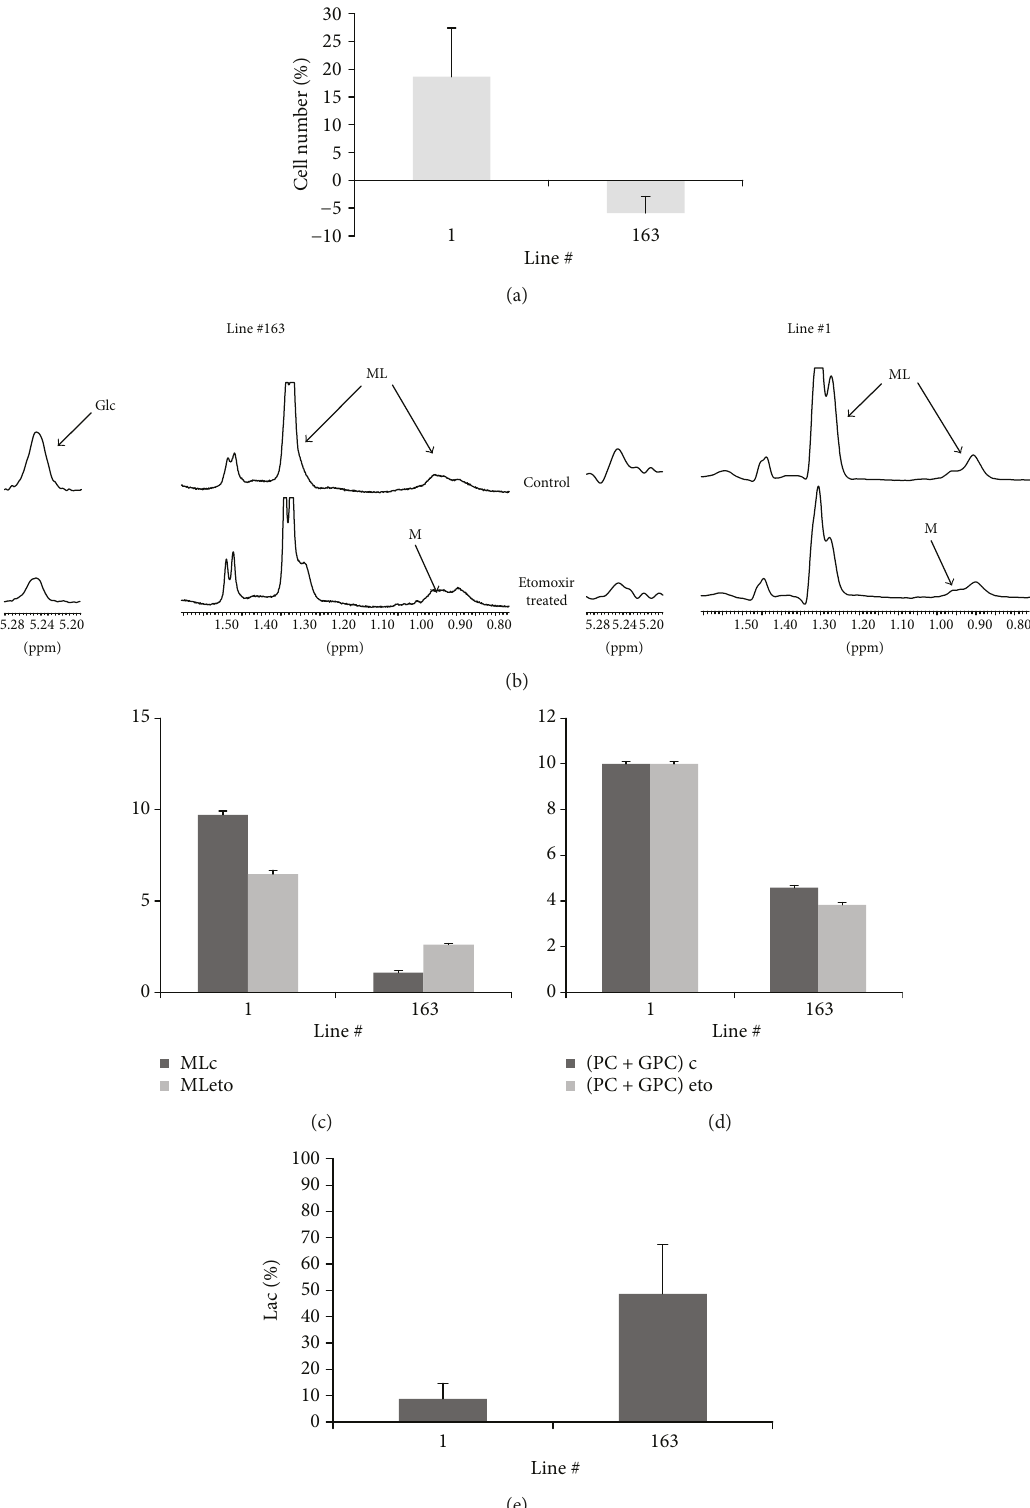
Figure 7: Analysis of the e ff ects induced by etomoxir treatment. (a) Changes in cell number percentage induced by 7-hour etomoxir treatment in cell lines #1 and #163. (b) E ff ects of etomoxir treatment on ML and Glc signals in 1D MR spectra of lines #1 and #163. Trend of ML (c) and PC+ GPC (d) signal intensities from 1D spectra of control and etomoxir-treated #1 and #163 line samples. (e) Percentage variation of lactate signal intensity measured compared to cell number ([(Lac/N)eto (Lac/N)con]/(Lac/N)con) 7h after etomoxir